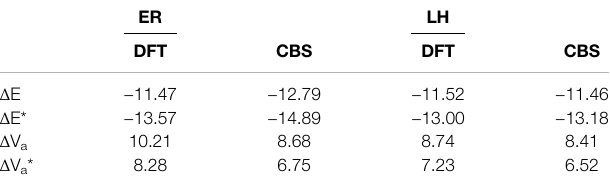
TABLE 4 | Comparison between ER and LH ZPE-corrected energies (kcal/mol).